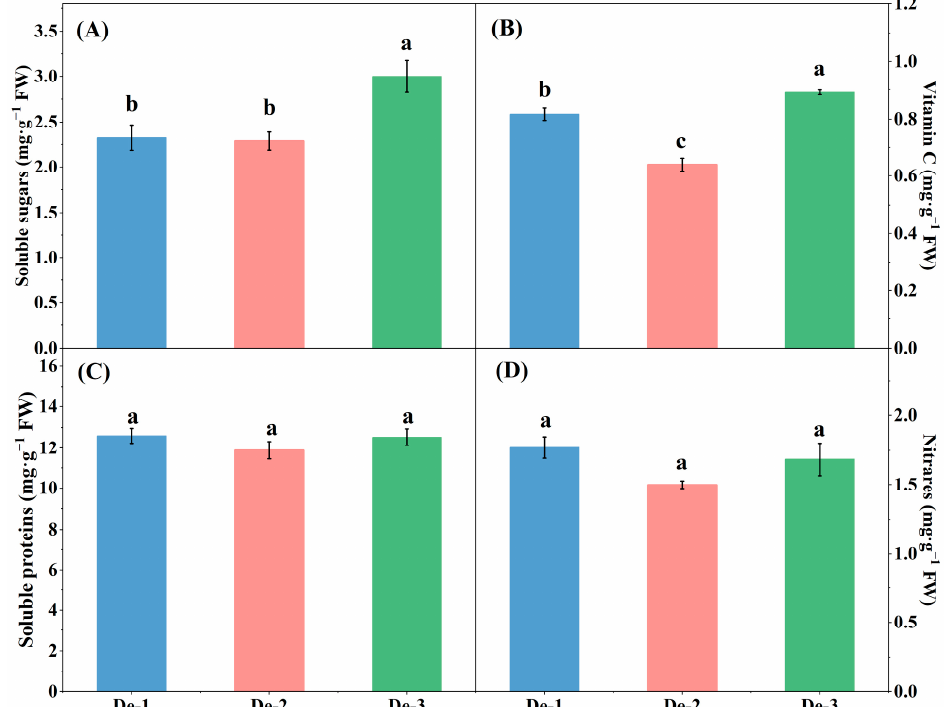
Figure 5. The contents of ( A ) soluble sugars, ( B ) vitamin C, ( C ) soluble proteins, and ( D ) nitrates of kale grown under different nutrient-solution depths. Different letters (a–c) marked upon the columns in the figure indicate significant differences between treatments by Duncan’s multiple ( p < 0.05), and vertical bars represent the standard margin of error.